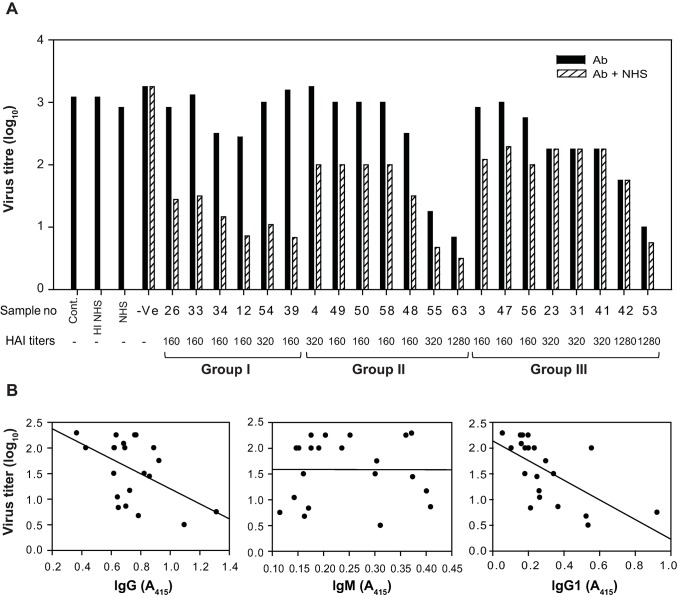
Influenza-specific complement-binding antibody response differs in different individuals.A) A total of 21 A(H1N1)pdm09 virus positive human sera were screened for the presence of complement binding antibodies. The virus was incubated with heat inactivated human sera sample collected from the A(H1N1)pdm09 virus infected individuals [HAI titer: 160–1280] in the presence or absence of normal human serum as a source of complement, and the infectious virus remained was titered by TCID50. Results represent mean of two independent experiments. Virus neutralization potential of serum antibodies in the presence of complement varied in different individuals. Based on the neutralization potential, sera are grouped as: Group I—substantial enhancement in neutralization in the presence of complement. Group II—moderate enhancement in neutralization in the presence of complement. Group III–negligible enhancement in neutralization in the presence of complement. B) Correlation between the virus-specific antibody levels in sera and the ability of the sera to neutralize the virus in the presence of complement. The A415 values are shown for comparison of antibody levels within the subclass of immunoglobulins. Significant correlation was observed only between neutralization potential of sera in the presence of complement and IgG (r = -0.501; p = 0.02) and its subclass IgG1 (r = -0.628; p < 0.002).